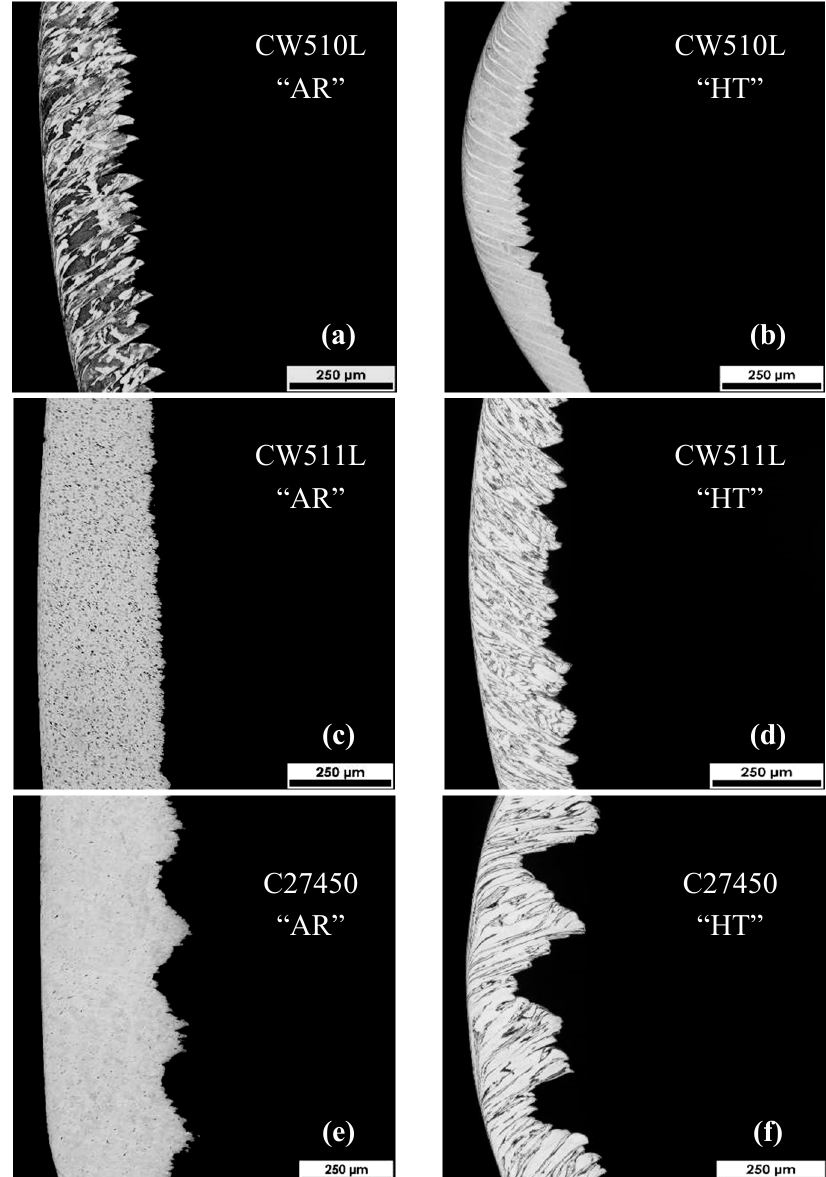
Figure 5. Optical micrographs of chip morphologies: ( a ) CW510L, as received, ( b ) CW510L, heat treated, ( c ) CW511L, as received, ( d ) CW511L, heat treated, ( e ) C27450, as received, and ( f ) C27450, heat treated.